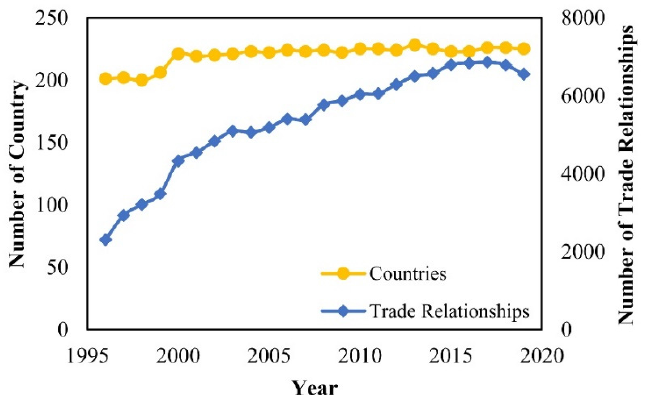
Figure 3. Evolution of the number of trade partners and trade relations.